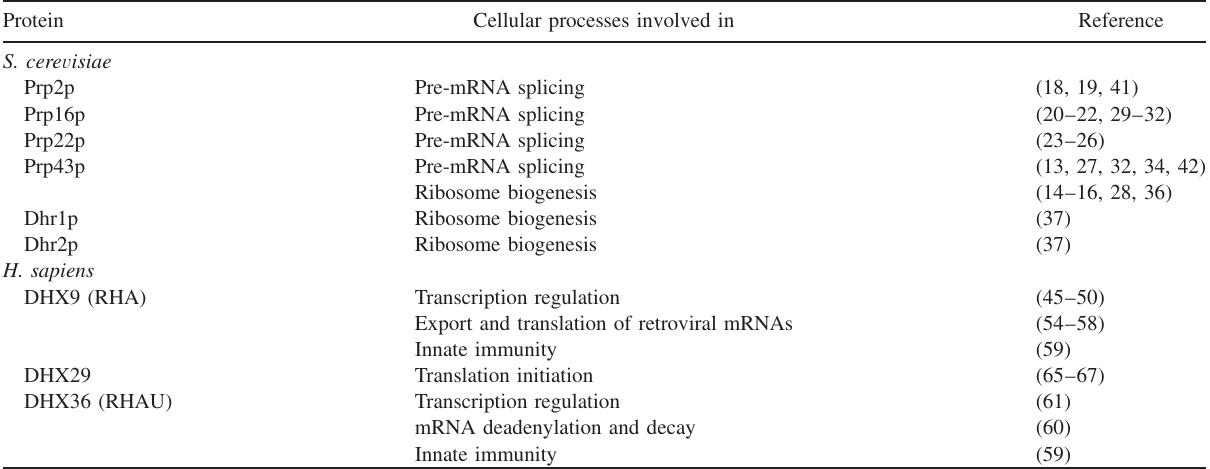
Table 1 Biological functions of DEAH/RHA helicases.